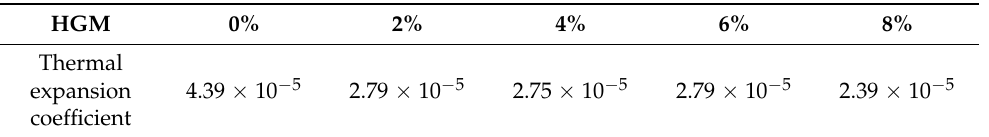
Table 1. Thermal expansion coefficient of HGM/epoxy resin composite. Adapted with